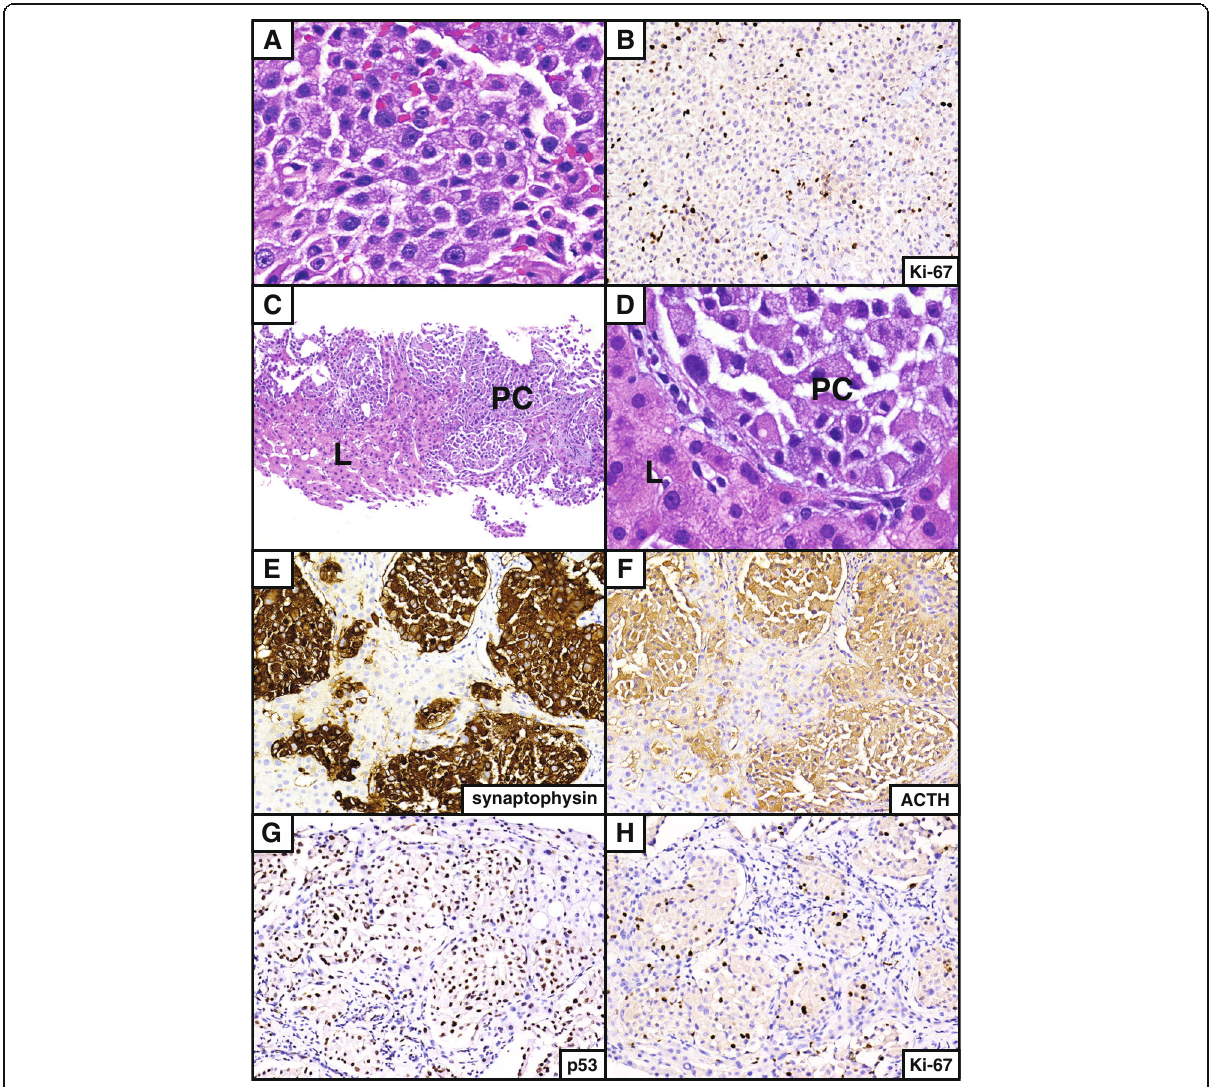
Fig. 2 Histology of the APA and pituitary carcinoma. Hematoxylin and eosin (H&E) stain of the recurrent sellar-region APA demonstrating mildly pleomorphic polygonal cells with distinct nucleoli ( a ). Immunohistochemical staining for Ki-67 yielded a proliferation index of 8 to 15% ( b ). H&E stained views of the metastatic pituitary carcinoma, with the carcinoma labeled “ PC ” and surrounding benign liver labeled “ L ” for reference ( c , d ). Note the similar histologic appearance to the recurrent sellar lesion above. Mitotic activity was not conspicuous and necrosis was not present in any of the three lesions. Immunostains for synaptophysin ( e ), ACTH ( f ) and p53 ( g ) all demonstrated diffuse immunoreactivity in the metastatic lesional cells. Ki-67 was positive in approximately 10% of tumor nuclei overall, with focal areas approaching 20% immunostaining ( h ). Original magnifications: a , 600×; b , 200×; c , 100×; d , 600×; and e – h ,